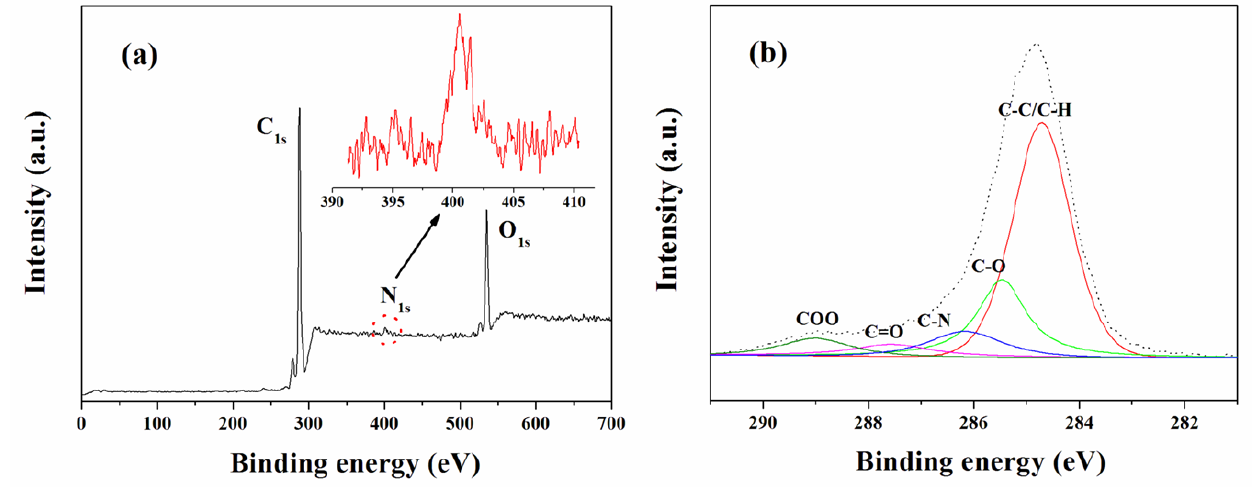
Figure 4. (a) XPS spectra and (b) high resolution spectra of C PE membranes. The inset of (a) shows N membranes. Reproduced with permission from Reference [58]. © 2009 Elsevier